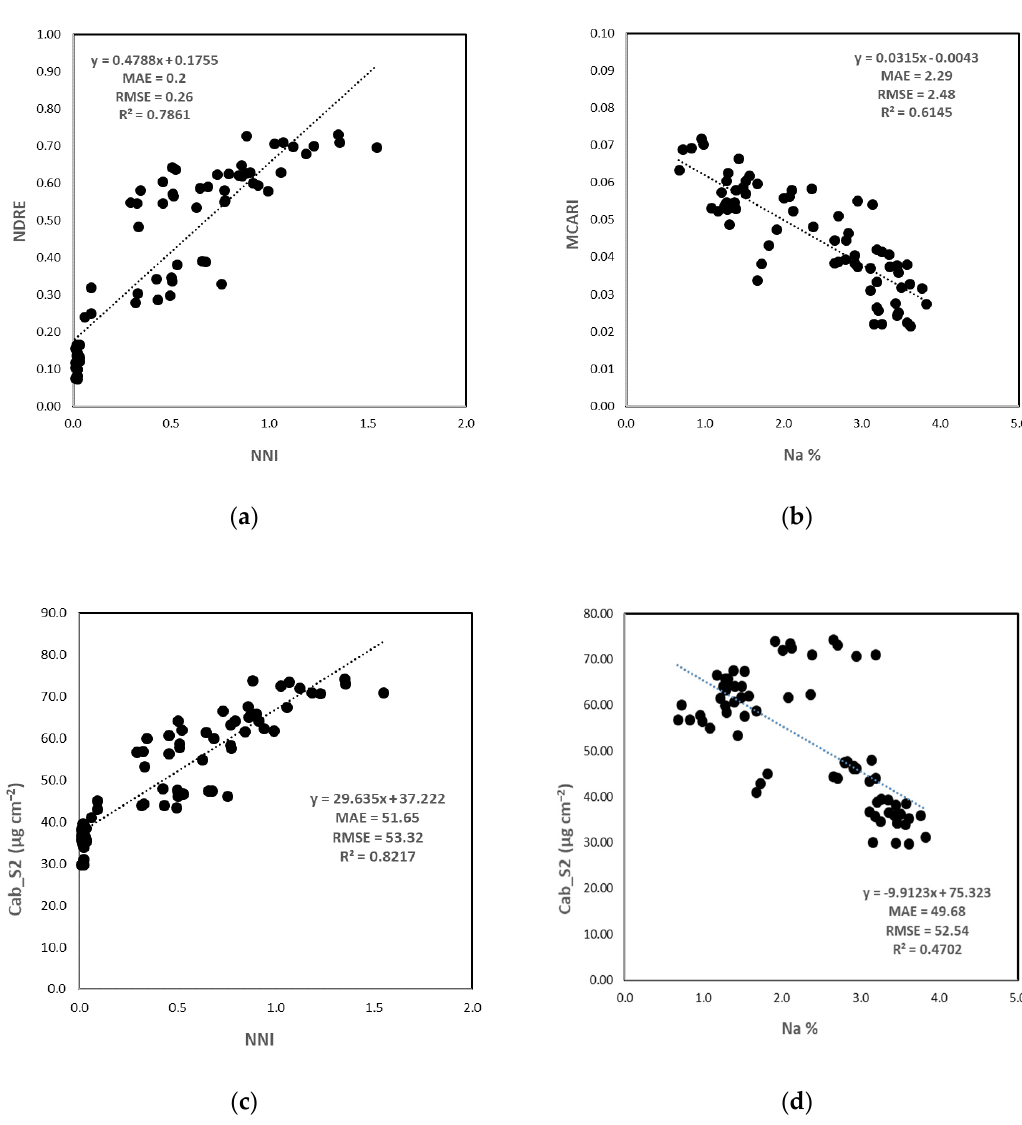
Figure 7. Scatterplots and statistics for S2_BVs and VIs derived from Sentinel-2 data (4 S2 images) and field data from 2nd leaf stage to silking stage in maize crop 2018. Relationships between: ( a ) normalized difference red edge index (NDRE) and nitrogen nutrition index (NNI) from ground data; ( b ) modified chlorophyll absorption in reflectance index (MCARI) and plant nitrogen content (Na%) from ground data; ( c ) chlorophyll content (Cab_S2 from S2 (GAI_S2/CCC_S2) and nitrogen nutrition index (NNI) from ground data; ( d ) chlorophyll content (Cab_S2 from S2 (GAI_S2/CCC_S2) and plant nitrogen content (Na%).